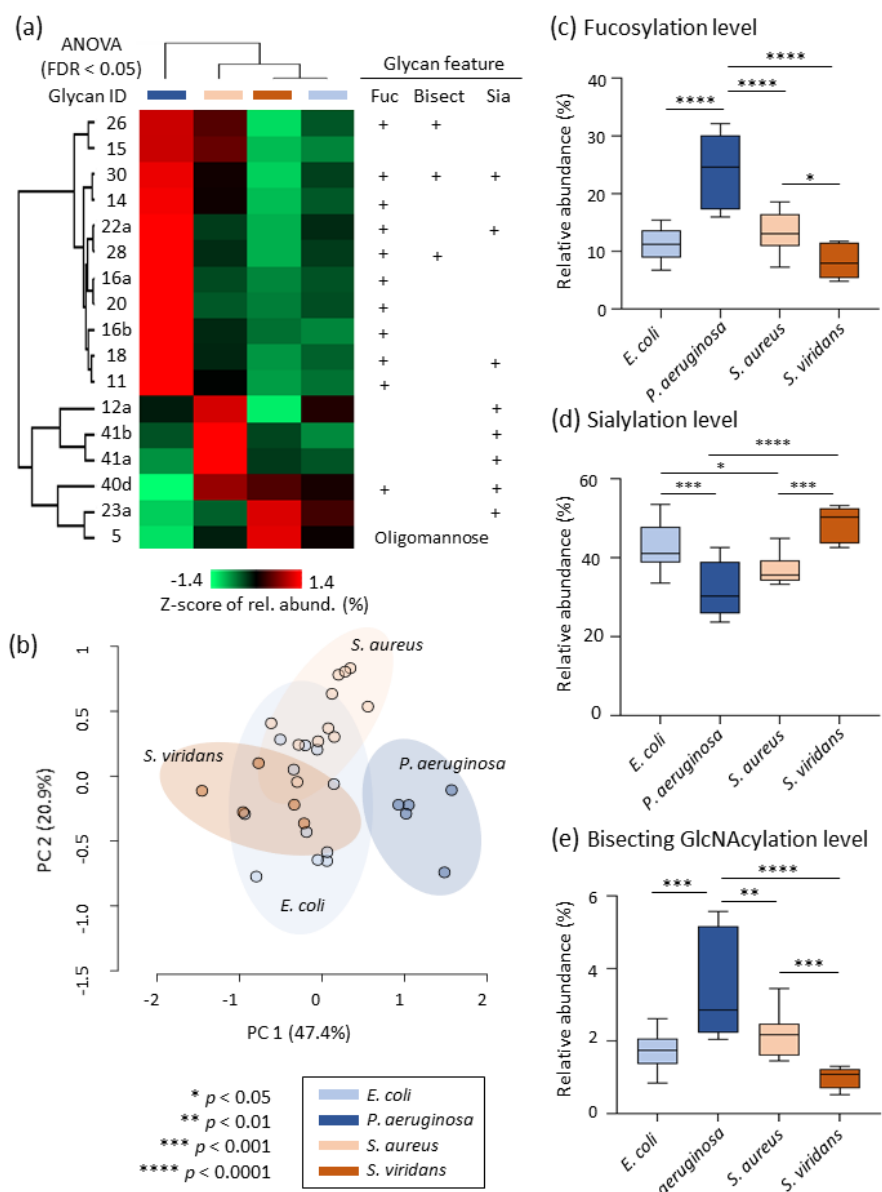
Figure 5. Pathogen-specific alterations of the serum N -glycome. ( a ) Heat-map representation illustrating the quantitative profile of selected glycans after Z-score transformation of the relative abundance data and cluster analysis using Euclidean distance and average linkage performed with Perseus. The selected glycans were a panel of 17 glycan isomers that were found to be differentially abundant in serum across the bacteremic patient groups (ANOVA followed by FDR correction, p < 0.05). Key structural features are indicated for these glycans. The P. aeruginosa -infected individuals displayed a starkly different serum N -glycome profile relative to other bacteremic patients. ( b ) Unsupervised PCA performed with the Metaboanalyst software using untransformed relative abundance data of the panel of 17 glycan isomers as input demonstrating a complete separation of P. aeruginosa -infected individuals from the other bacteremic patient groups. The P. aeruginosa -infected individuals displayed aberrant levels of ( c ) fucosylation, ( d ) sialylation, and ( e ) bisecting GlcNAcylation (ANOVA and Fisher’s LSD, p <